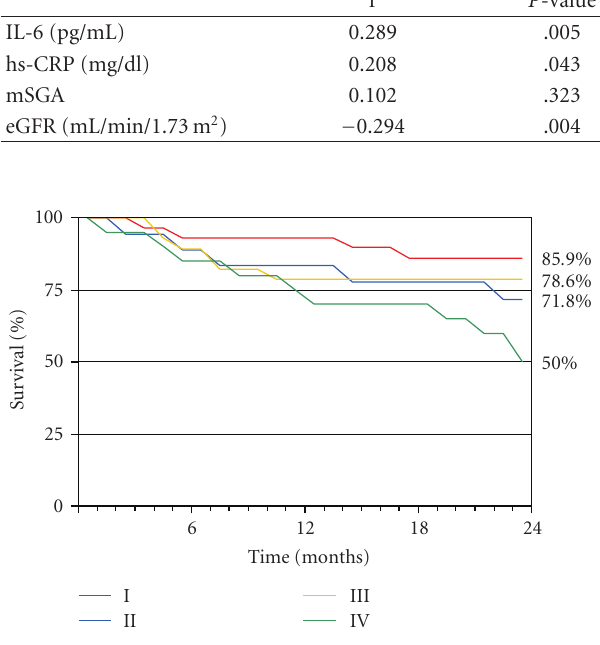
Figure 1: Actuarial survival at 24 months. Group IV showed the worst survival (logrank 8.31, P =